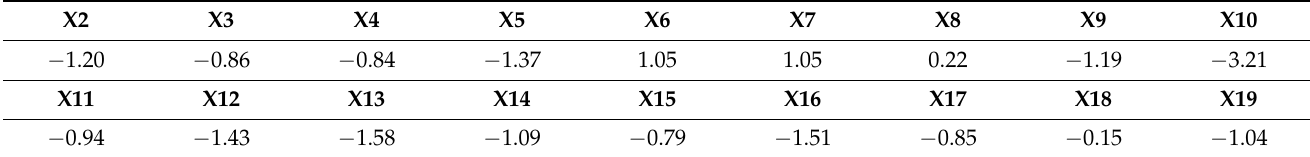
Table 6. Values of skewness coefficient for continuous independent variables after transformation according to Formula